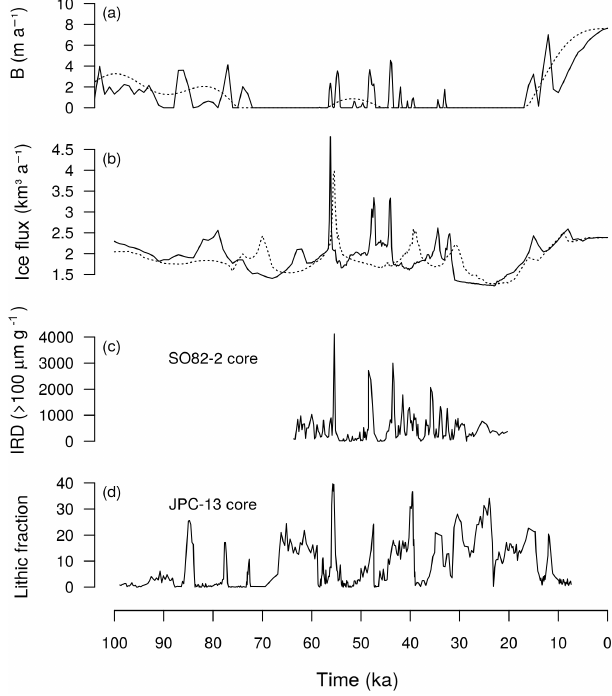
Figure 8. Simulated submarine melt (a) and simulated ice flux averaged over the southeast GrIS region (b) are compared to ice- discharge proxy data taken from the SO82-2 (c) and the JPC-13 (d) sediment cores in the North